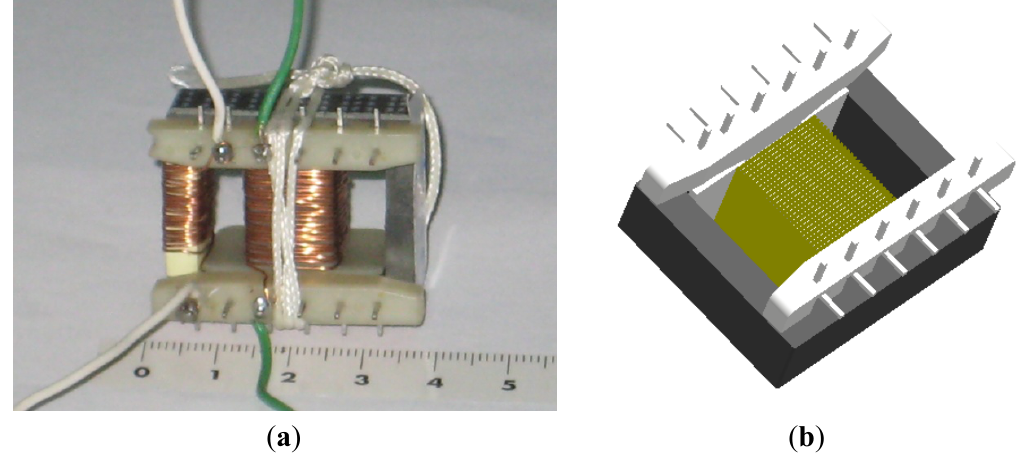
Figure 3. ( a ) Real transformer with E34/14/9 core and two windings of 28 turns; ( b ) E34/14/9 geometry used in the 3D simulations.